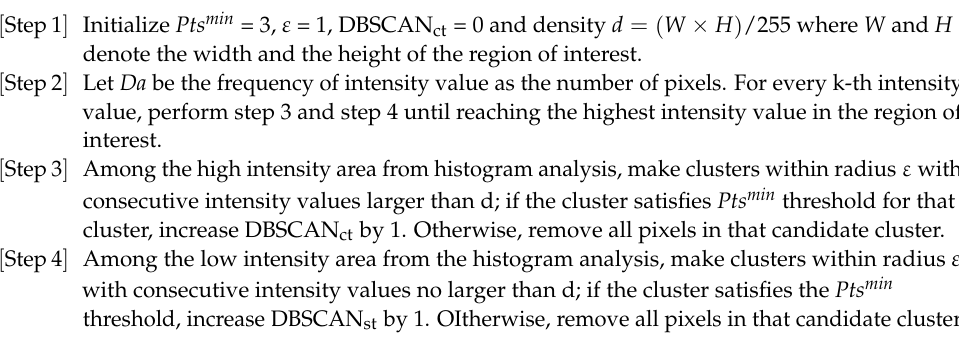
Algorithm 1. DBSCAN process.